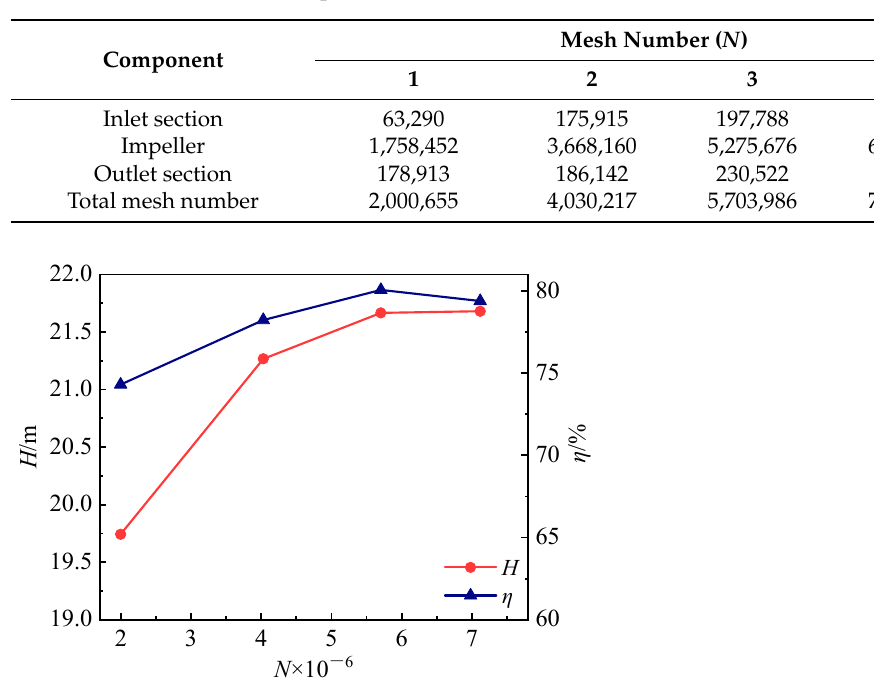
Figure 2. Meshes of HAMP. Table 2. Mesh cells of different parts.